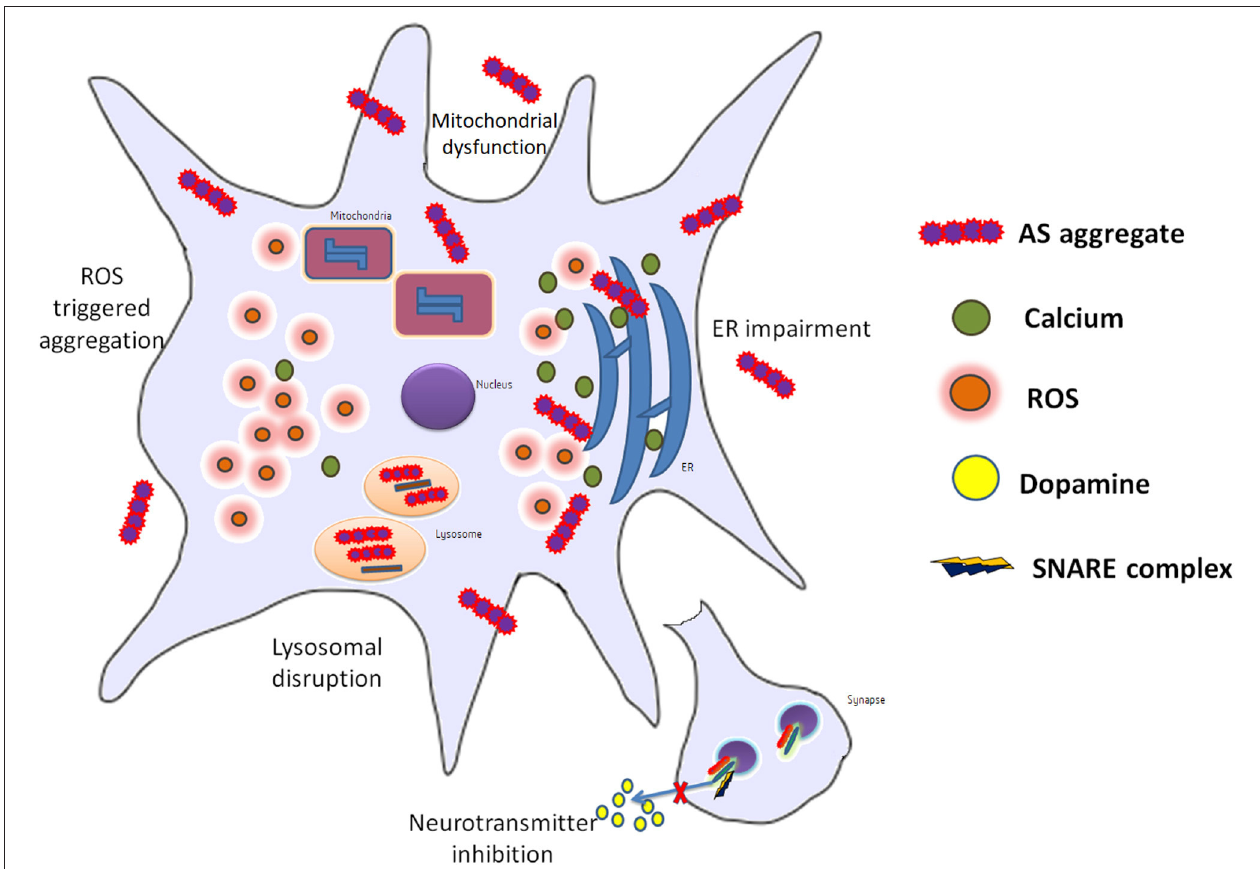
FIGURE 2 | Info graph elucidating the various repercussions that can be observed in a neuron during